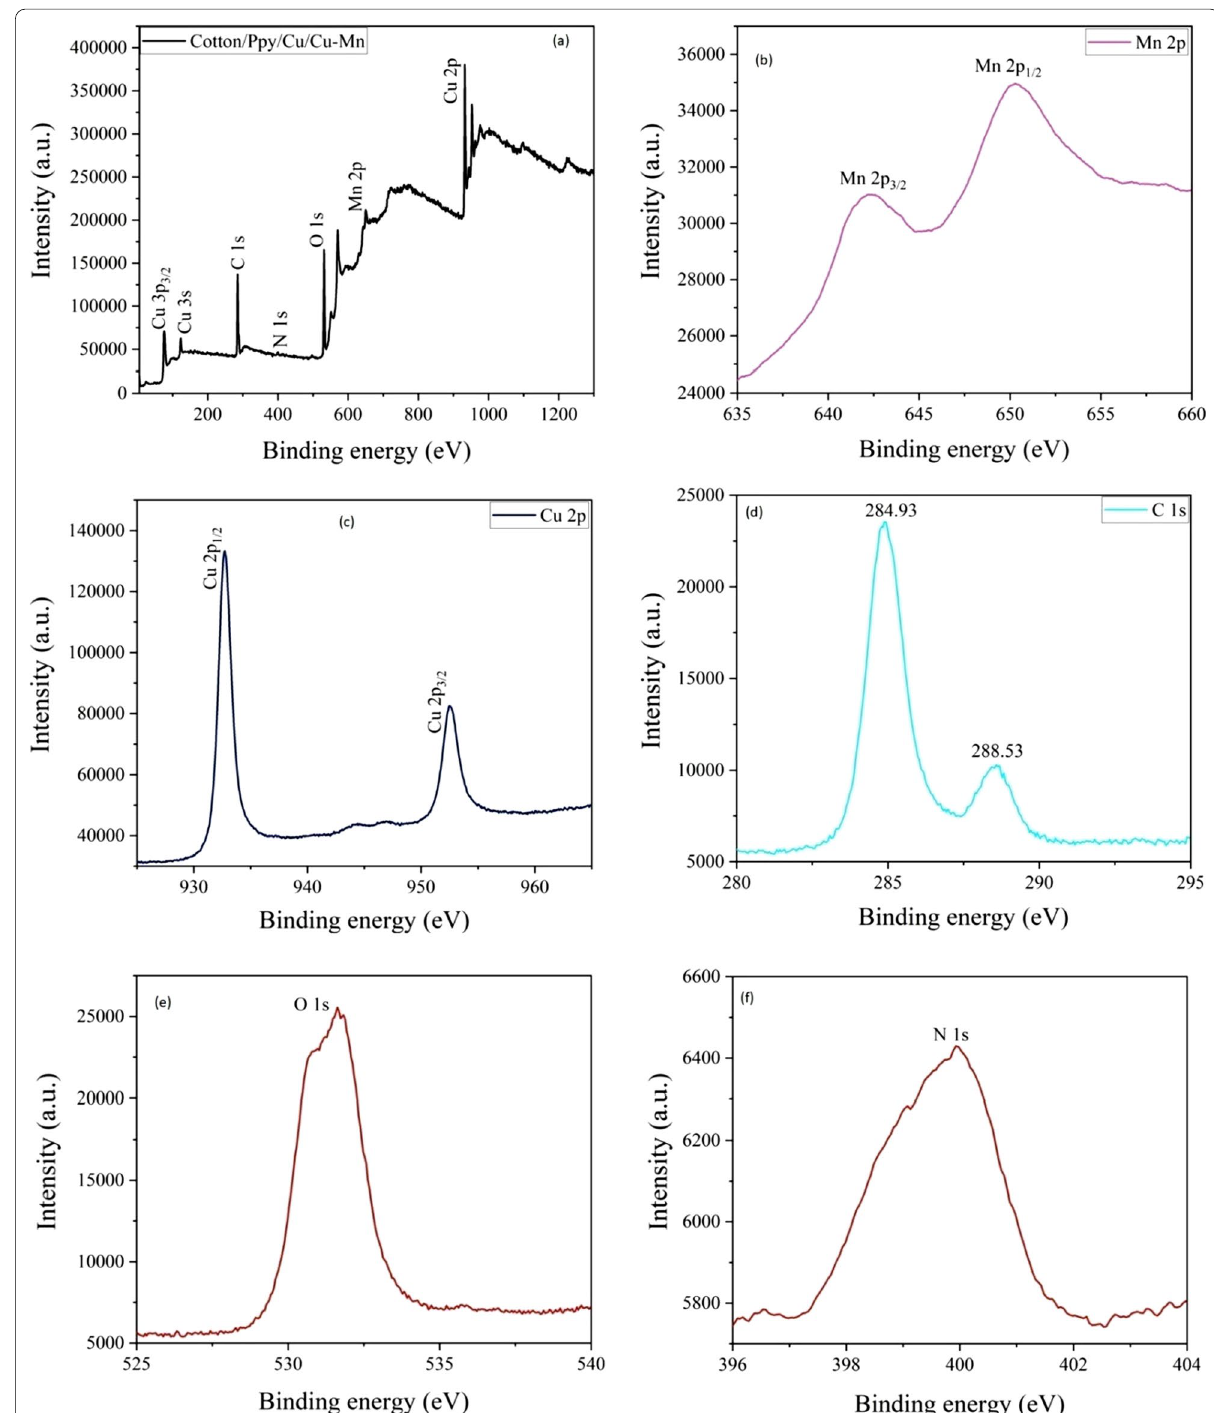
Fig. 3 XPS survey spectra of a ppy/Cu/Cu–Mn-treated cotton fabric, b Mn 2p, c Cu 2p, d C 1 s, e O 1 s and f N 1